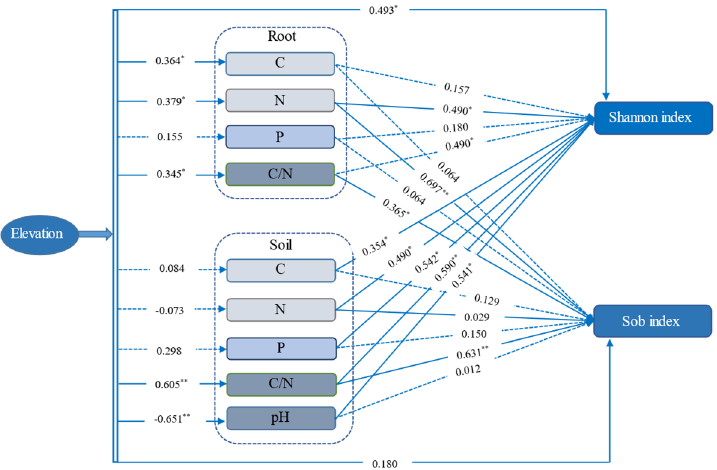
Figure 6. The relationships among elevation, soil factors (C, N, P, C/N, and pH), plant factors (C, N, P, and C/N), and AMF diversity indices are based on OTU level. Note: The effect of altitude on soil and root is expressed as a correlation coefficient, while the effects of soil and root factors on diversity indices are represented by standard regression coefficients. Blue solid represents significant positive or negative effects. Blue dashed represent nonsignificant paths. ** means p < 0.01; * means p < 0.05,